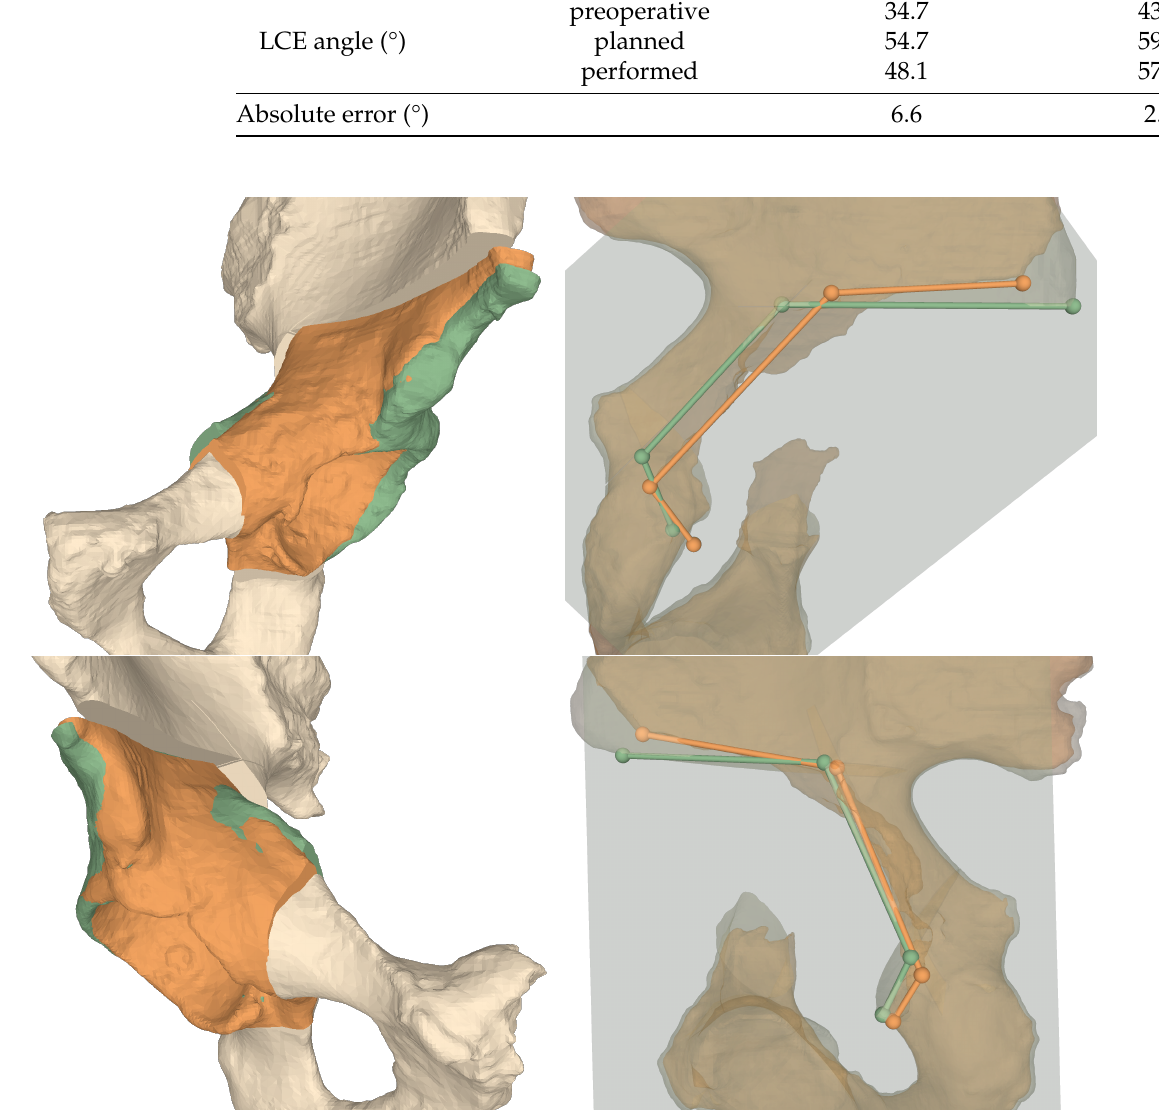
Figure 8. 3D comparisons between preoperative plans and postoperative models for Cadaver 1 ( top row ) and Cadaver 2 ( bottom row ). Left column shows the fragment orientations, right column the projected osteotomy starting points and their connecting vectors. Green: planned, orange: